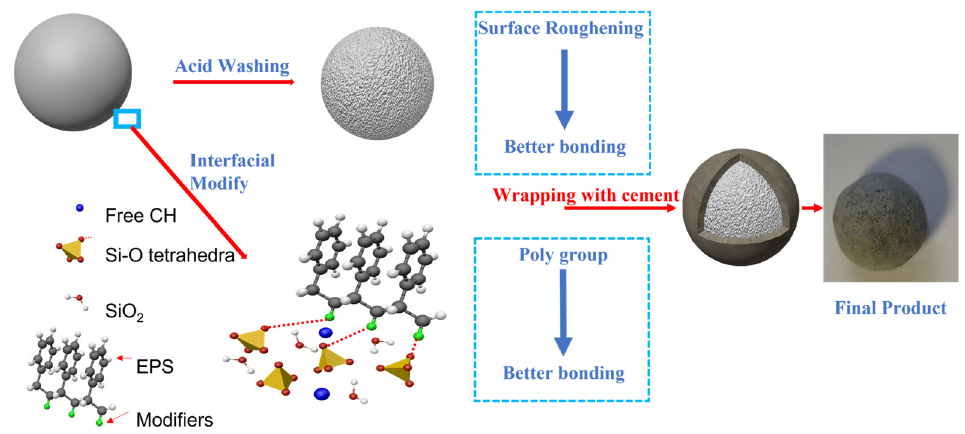
Figure 1. Flow chart of the research.